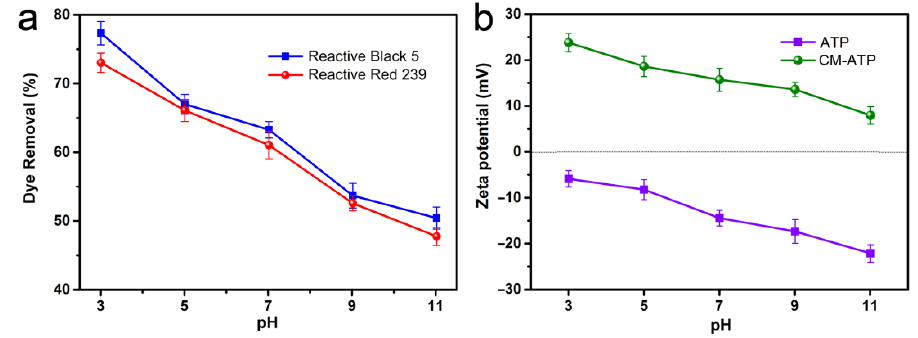
Figure 6. Effect of solution pH on dye removal of CM-ATP ( a ). The zeta potential values of ATP and CM-ATP ( b ).